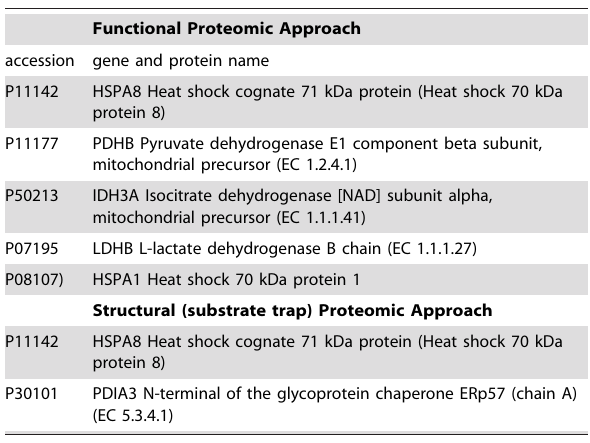
Table depicting the identified proteins from spot excision of the silver-stained IEF/2D gels in the functional and substrate trap proteomic approach.